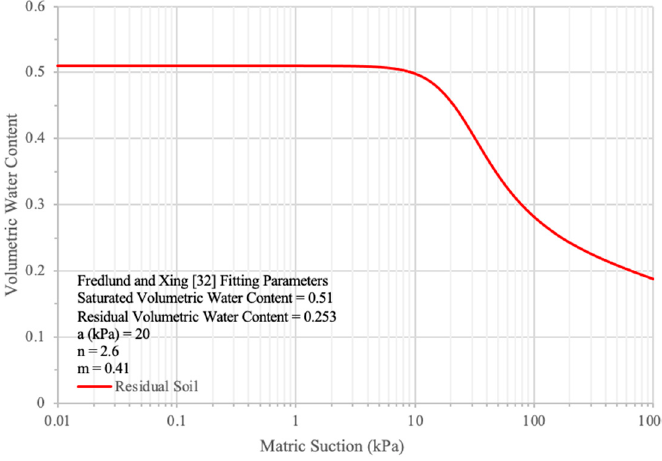
Figure 3. Soil–water characteristic curve for BTG residual soil.